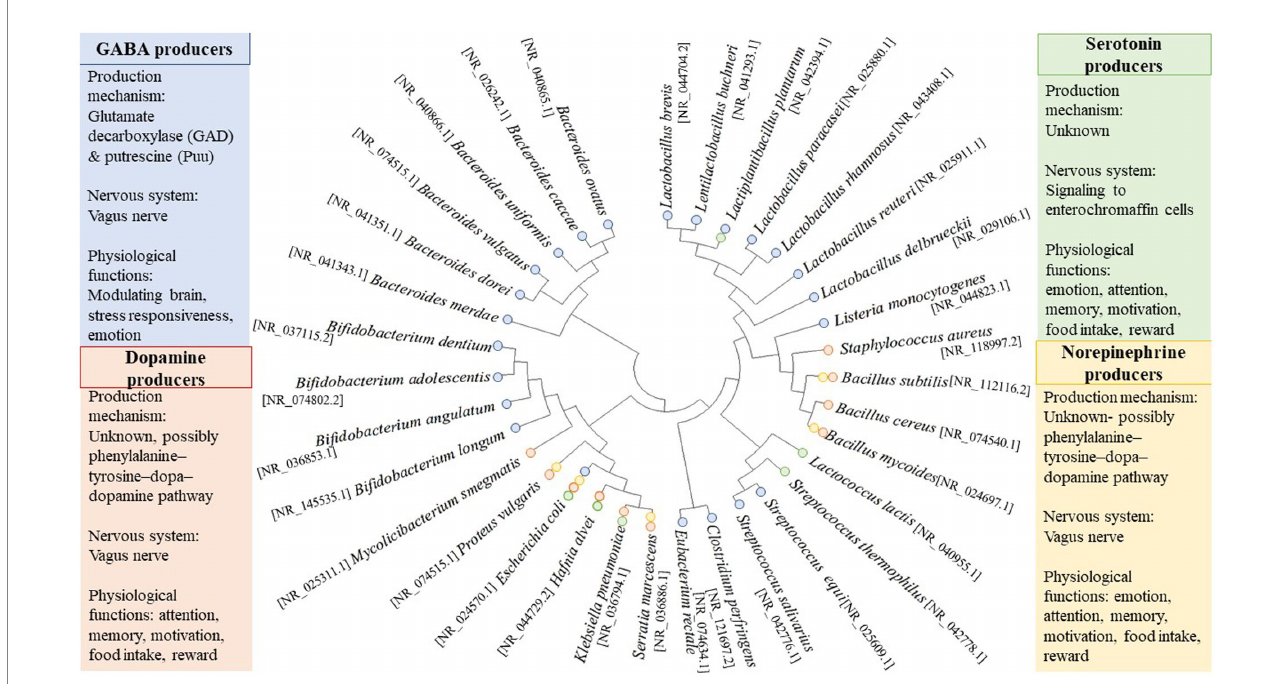
FIGURE 2 Phylogenetic diversity of neurotransmitter-producing bacteria. Sequences are based on published whole-genome or partial sequences from the NCBI Reference Sequence (NCBI RefSeq Targeted Loci Project, Direct Submission, National Center for Biotechnology, Information, NIH, Bethesda, MD 20894, USA). GeneBank accession numbers for the 16S rRNA sequence are shown in the bracket. The phylogenetic tree was constructed using MEGA 11 software (version 11.0.10). Briefly, the evolutionary history was inferred using the Neighbor-Joining method (Saitou and Nei, 1987). The bootstrap consensus tree inferred from 1,000 replicates represents the evolutionary history of the taxa analyzed (Felsenstein, 1992). Branches corresponding to partitions reproduced in less than 50% of bootstrap replicates are collapsed. The evolutionary distances were computed using the Tamura 3-parameter method (Tamura, 1992) and are in the units of the number of base substitutions per site. This analysis involved 34 nucleotide sequences. All ambiguous positions were removed for each sequence pair (pairwise deletion option). There were a total of 1,606 positions in the final dataset. Evolutionary analyses were conducted in MEGA11 (Tamura et al.,